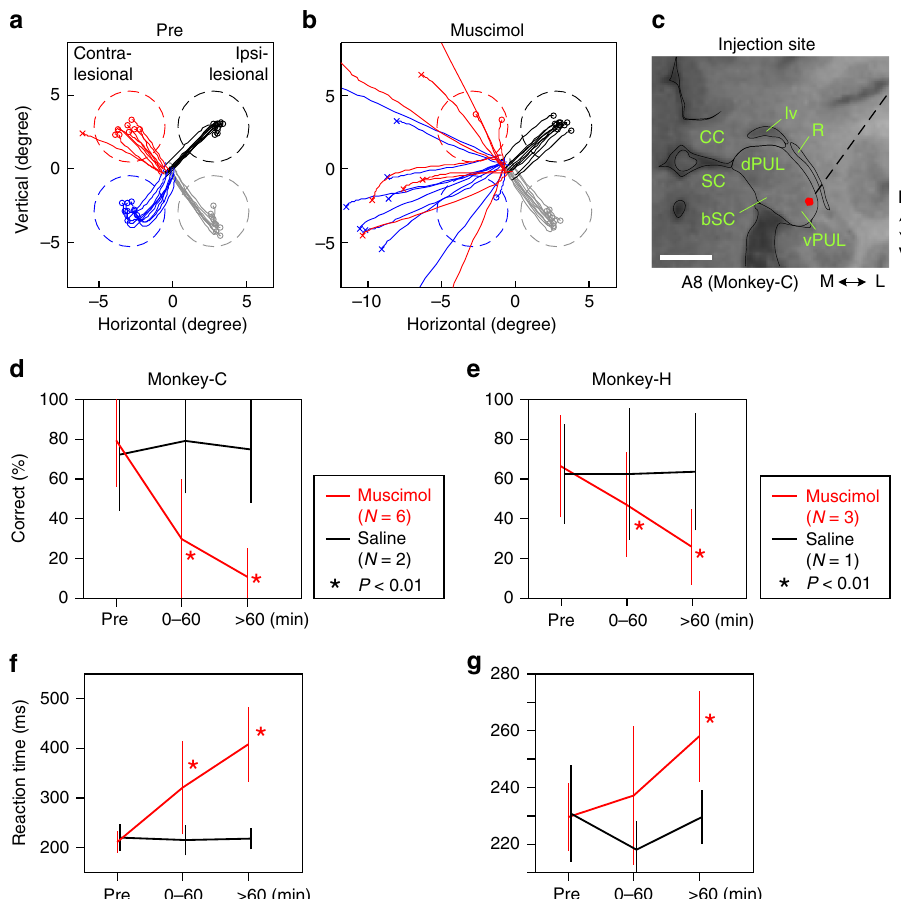
Fig. 3 Inactivation of the vlPul impaired the VGS. a , b Representative trajectories of saccades in the VGS task before ( a ) and 60 min after ( b ) the injection of 0.5 μ L muscimol. The target was presented at the center of the dashed circle, which indicates the target window. The saccade endpoint was depicted as o (correct saccade, inside of the window) or x (fail, outside). Different color corresponds to the difference of target location. The target contrast was 0.85. c Red dot indicates the injection site for b . The dashed line indicates the penetration of the injection needle. Scale bar: 5 mm. d , e The averaged ratios of the correct saccade for each time window (Pre: before injection. 0 – 60: 0 to 60 min after the injection. >60: after 60 min. Red line: muscimol injection. Black line: saline injection). The correct ratios were signi fi cantly decreased in muscimol injections (asterisk: P < 0.01, t test, compared with pre) in both monkeys. No signi fi cant difference was found in saline injections ( P > 0.05, t test). The number of days used for the average is indicated as N in each inset. Error bar indicates SD. The target contrast was 0.85 for Monkey-C and 0.6 for Monkey-H. Number of trials for each target in each time window were 4 – 11 for Monkey-C and 7 – 23 for Monkey-H. Number of targets for the average were 21 for Monkey-C and 12 for Monkey-H. Non-averaged results are shown in Supplementary Figure 2. f , g The averaged VGS reaction time is plotted in the same manner as d , e , respectively. The prolonged reaction time was observed after the muscimol injection in